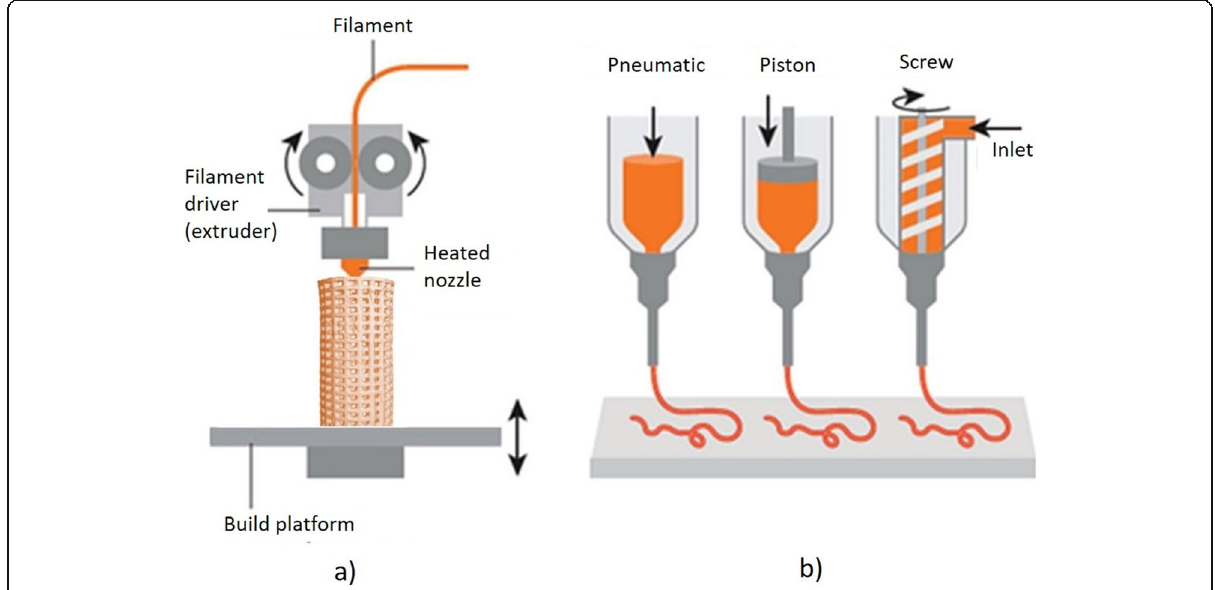
Fig. 3 Schematic representation of extrusion-based techniques, namely a FDM method; b DIW method. Adapted from